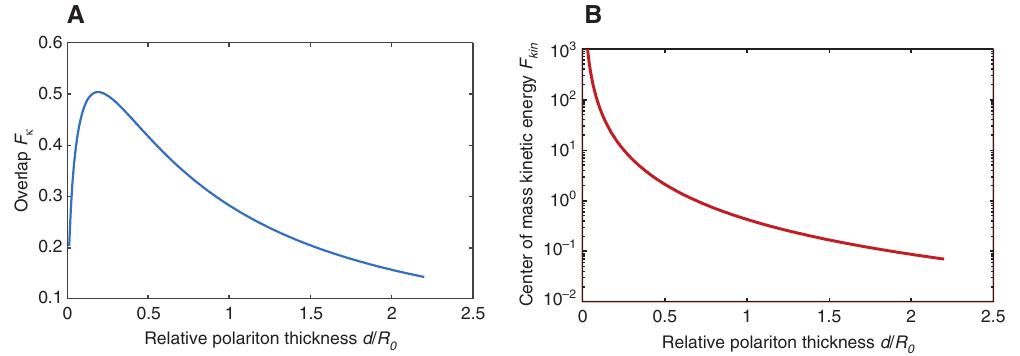
and (B) center of mass kinetic energy F κ